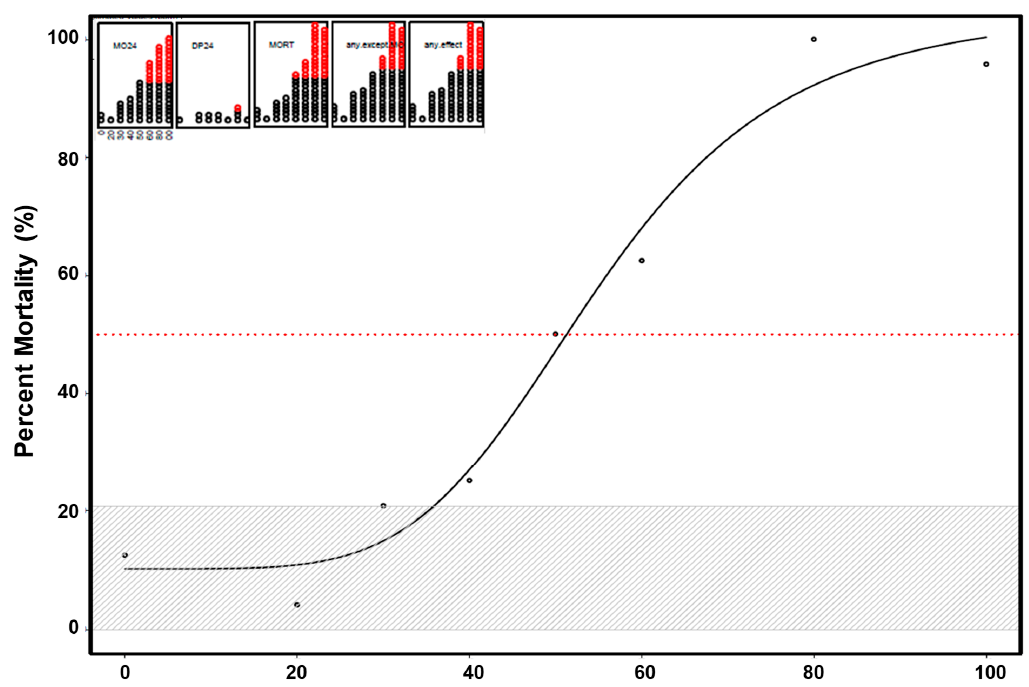
Figure 1. Incidence of overt toxicity responses to DCB-230 at 24 and 120 hpf. The top left inset is a depiction of 5 endpoints—two at 24 h (MO24 = mortality, DP24 = delayed development progression), and total mortality at five days (MORT). Two summary endpoints indicate individuals with any morbidity (any.except.MO), and any morbidity + mortality exhibited (any.effect). Each affected individual is illustrated as a circle and once a statistical threshold is passed, the individual is depicted as red. The logistic regression is shown over seven concentrations, with an EC50 of 54.8 µg/mL (red dotted line). The gray hash represents the two means’ standard deviations around the control. Statistical significance was determined using a Fishers Exact Test, p < 0.01.